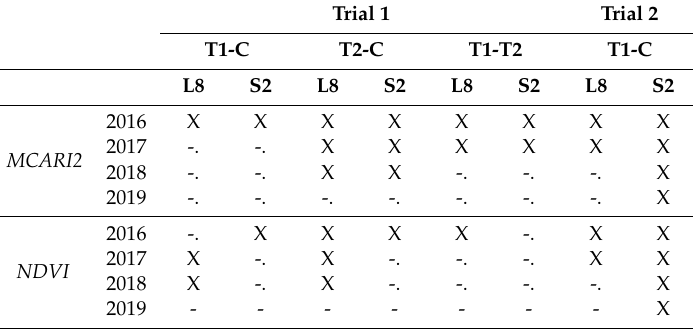
Table 5. ANOVA data comparing AUCs for MCARI2 and NDVI for both satellites (L8: Landsat 8; S2: Sentinel 2), for all treatments in both trials. X indicates where the di ff erence between treatments (C: Control; T1: treatment 1; T2: treatment 2) is significant ( p < 0.05), and the dash (-)., where it is not. Trial 1 Trial 2 T1-C T2-C